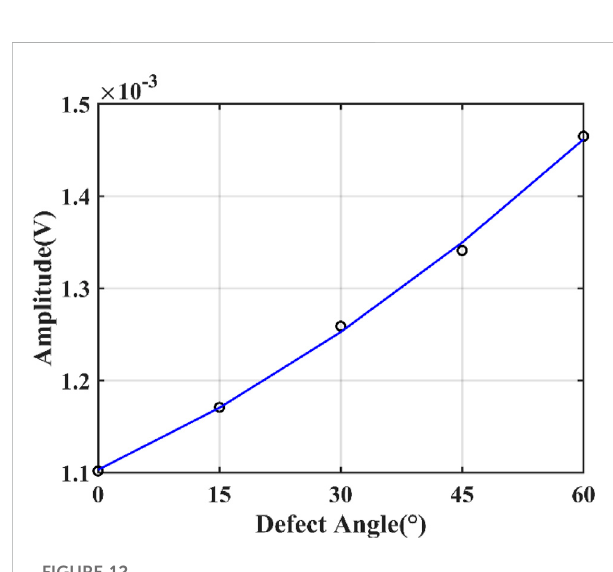
FIGURE 12 Circumferential angle variation pattern of cement bonding